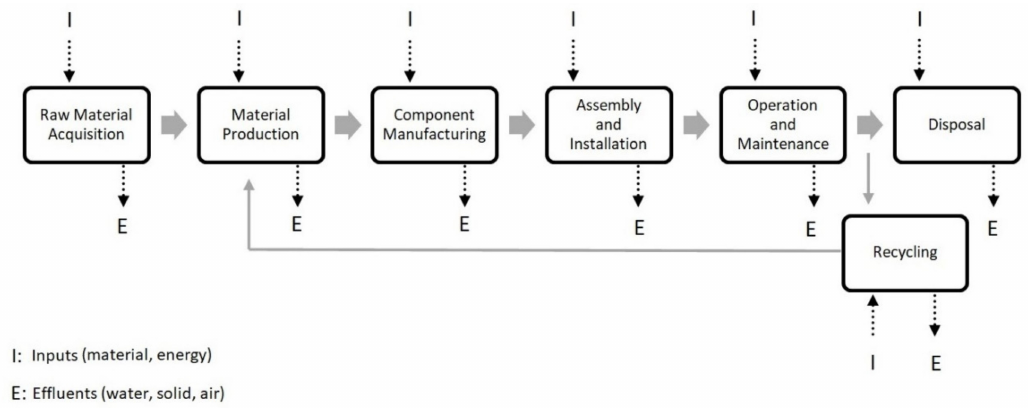
Figure 1. Stage of LCA analysis for photovoltaic modules